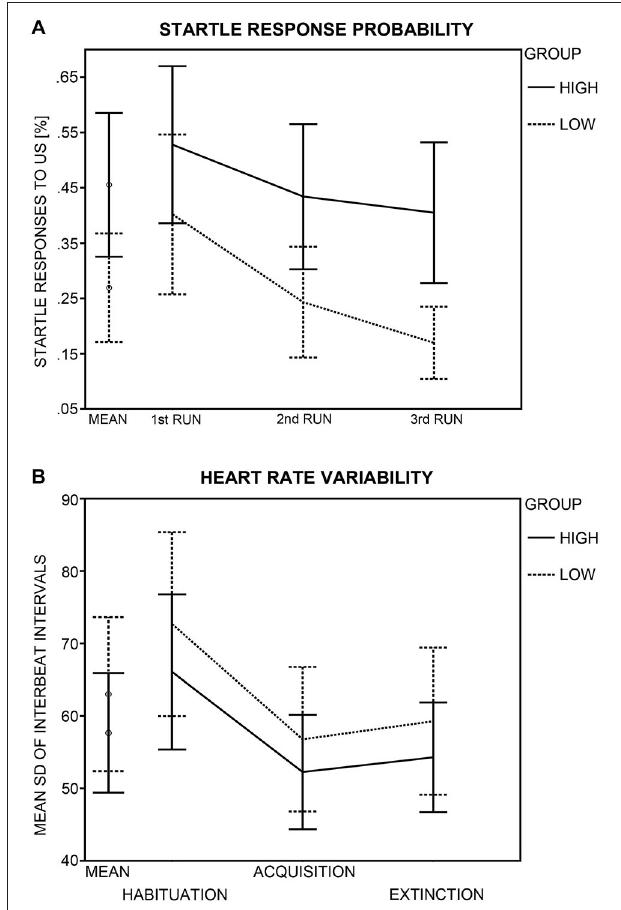
FIGURE 4 | Group differences in startle response probability and heart rate variability (HRV) . (A) Probability of a startle eye-blink response to the unconditioned stimulus (US) during acquisition (in %) is displayed for the high (crosses) and low (diamonds and solid lines) anxiety groups. Probabilities (95% confidence intervals) are shown for the mean of all acquisition runs and for each acquisition run (1st, 2nd, 3rd) separately. (B) HRV (95% confidence intervals) as calculated by the standard deviation of the interbeat interval (SDNN) is shown for the high and the low anxiety groups as mean across all MultiCS conditioning phases and for each phase (habituation, acquisition, extinction) separately.